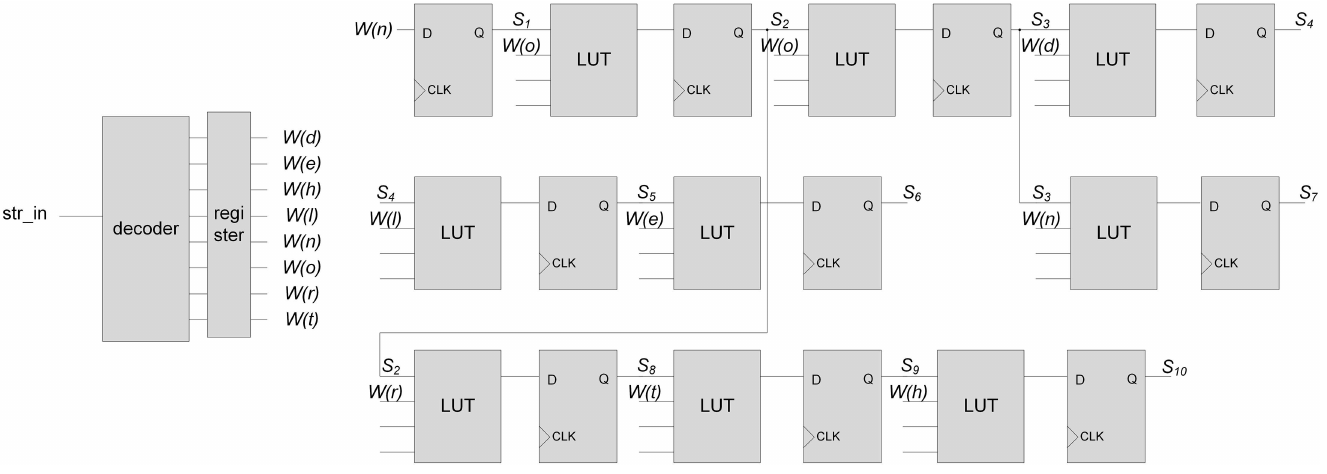
Fig 2. Circuit diagram of the pipelined NFA in Fig